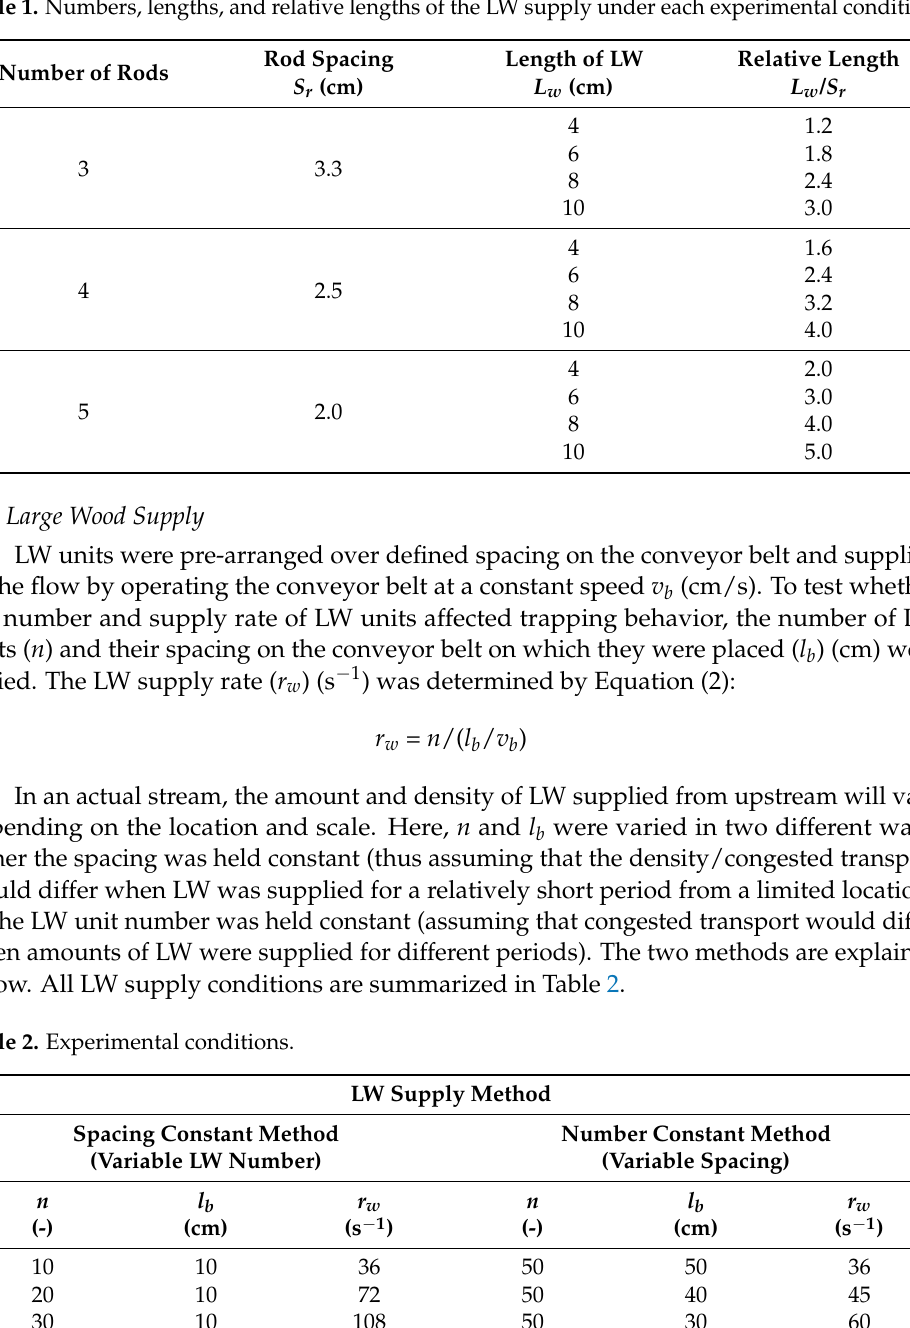
Table 1. Numbers, lengths, and relative lengths of the LW supply under each experimental condition.